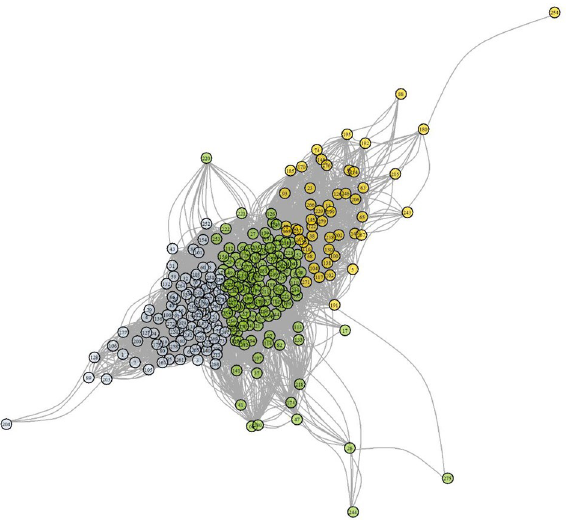
Figure 2. Network structure of temperature time series in the three-cluster solution. Network layout was determined using Fruchterman–Reingold algorithm. Gray, green, and gold colors represent clusters 1, 2, and 3, respectively. Figure produced using R Core Team (2021). R: A language and environment for statistical computing. R Foundation for Statistical Computing, Vienna, Austria. URL https:// www.R- proje ct. org/.